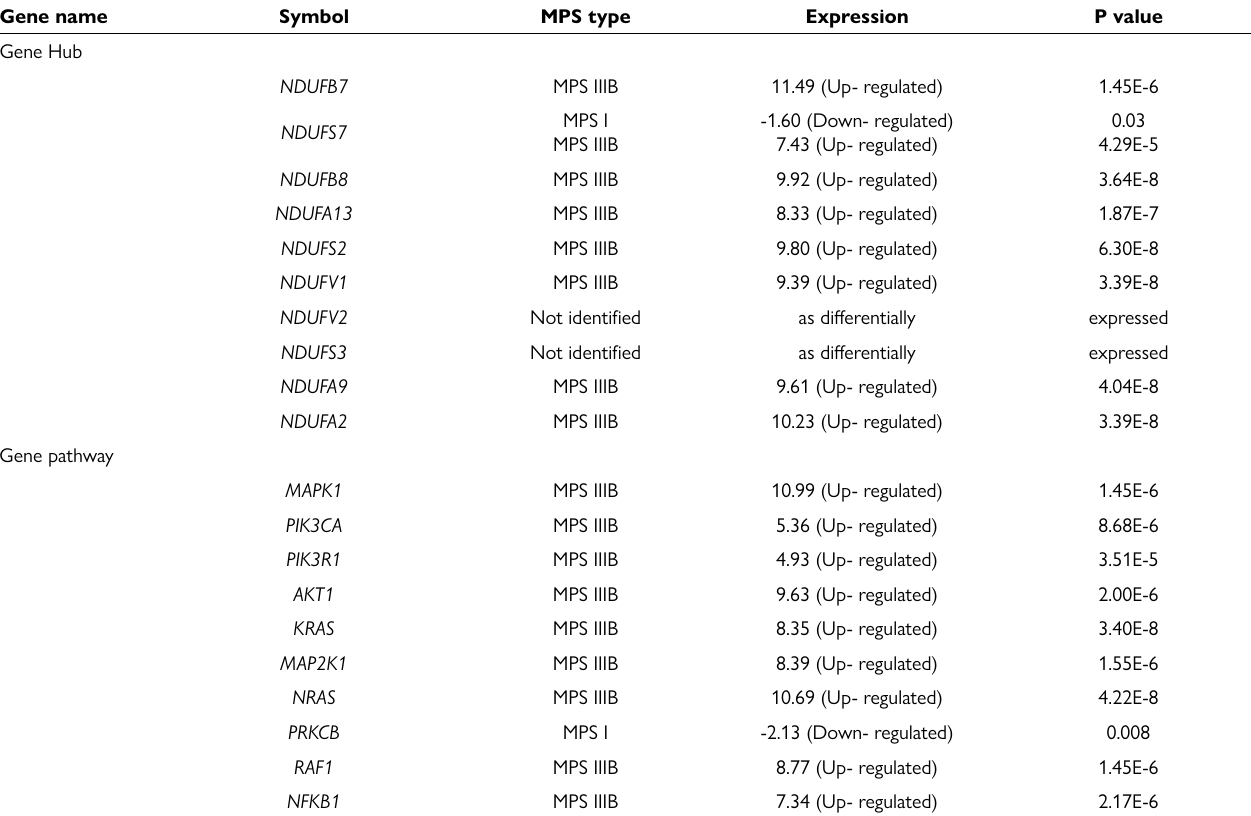
Table 3. Gene expression analysis of hub genes and most frequent genes of the pathway